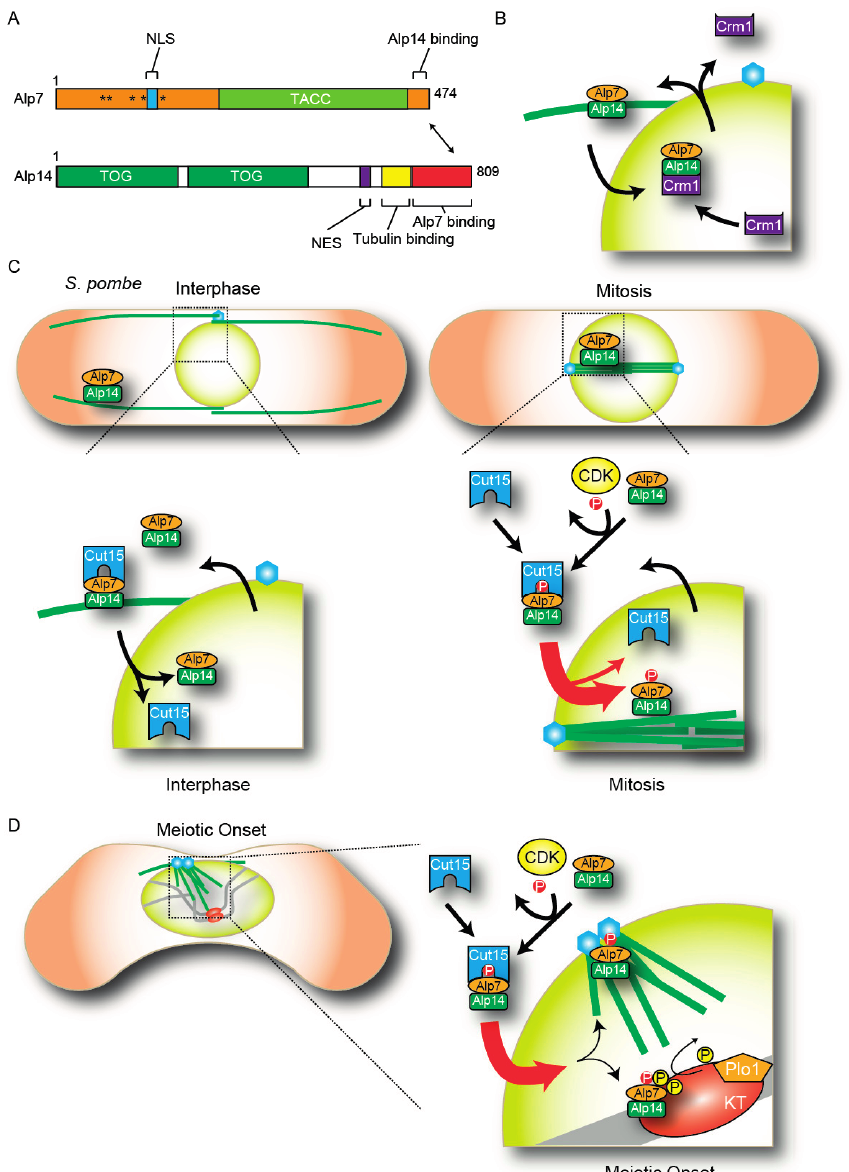
Figure 2. Nucleocytoplasmic shuttling of the Alp7-Alp14 complex in fission yeast. ( A ) Architectures of Alp7/TACC and Alp14/TOG. Alp7 has a nuclear localization signal (NLS) in its N-terminal half, whereas Alp7 interacts with Alp14 through its C-terminal end. Alp14 has a nuclear export signal (NES) in its middle region. Asterisks show the cyclin-dependent kinase (CDK) phosphorylation sites in Alp7. ( B ) The export of the Alp7-Alp14 complex. The NES in Alp14 plays a role in the nuclear export of the complex. ( C ) How the nuclear import of Alp7-Alp14 is modulated through the cell cycle. Left: During interphase, Alp7-Alp14 shuttles between the nucleus and the cytoplasm through the association of the NLS in Alp7 and importin- α /Cut15. Right: During mitosis, CDK phosphorylates Alp7 to accelerate the import activity of the complex and to promote spindle assembly. ( D ) Localization of Alp7-Alp14 at the onset of meiosis I. Alp7-Alp14 localizes to kinetochores (KT) even before microtubules that emanated from spindle pole bodies (SPBs) attach to the